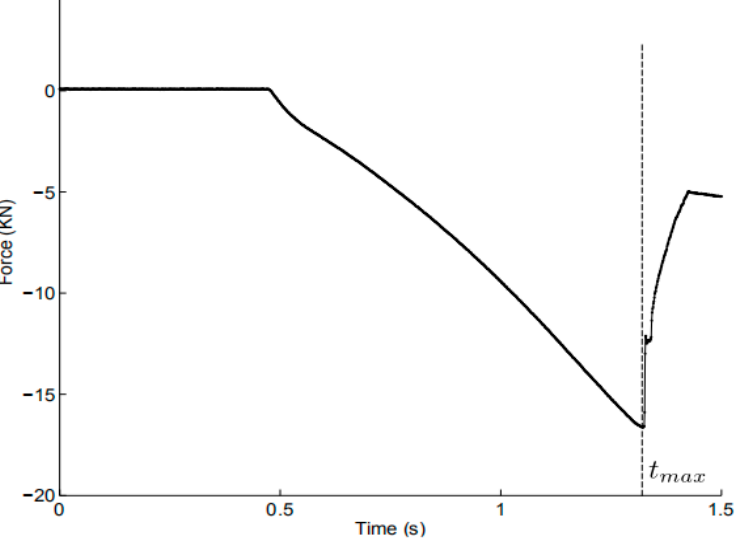
Figure 6. Evolution of recorded punch force in the Marciniak test.